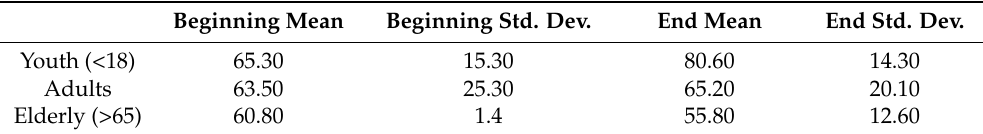
Table 1. Mean and Std. dev. values for the System Usability Scale (SUS) questionnaire. This table presents mean values from data collected at the beginning and at the end of user testing, and its standard deviation. Beginning Mean Beginning Std.